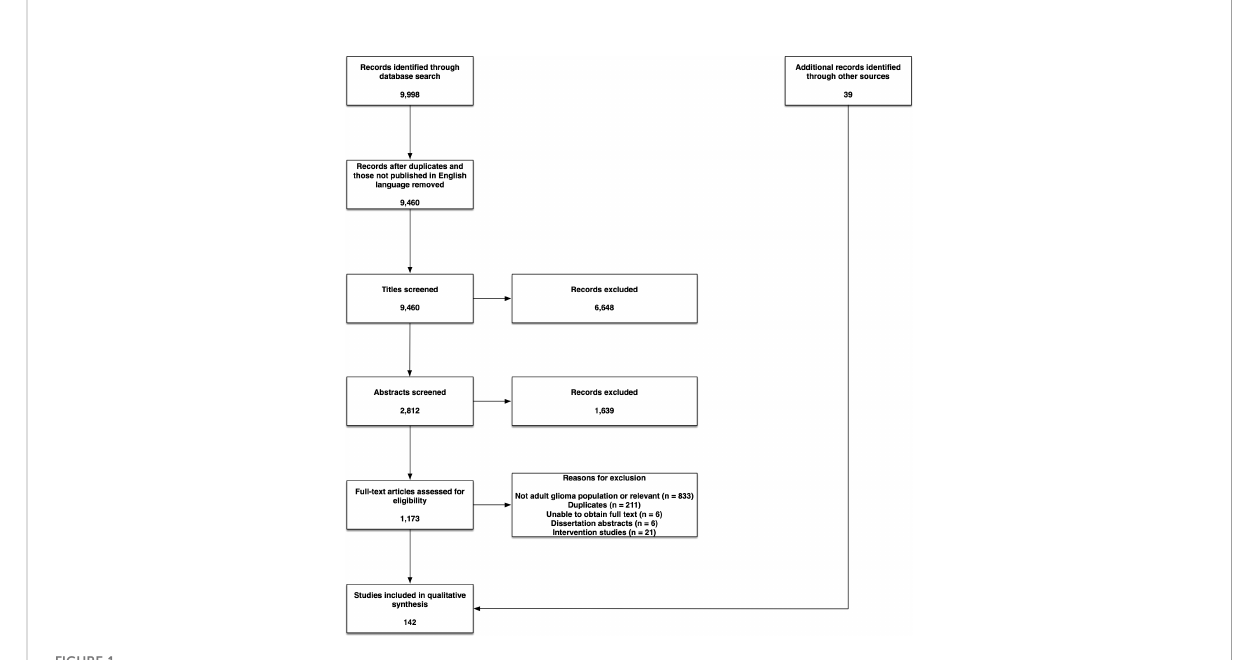
FIGURE 1 Study fl ow